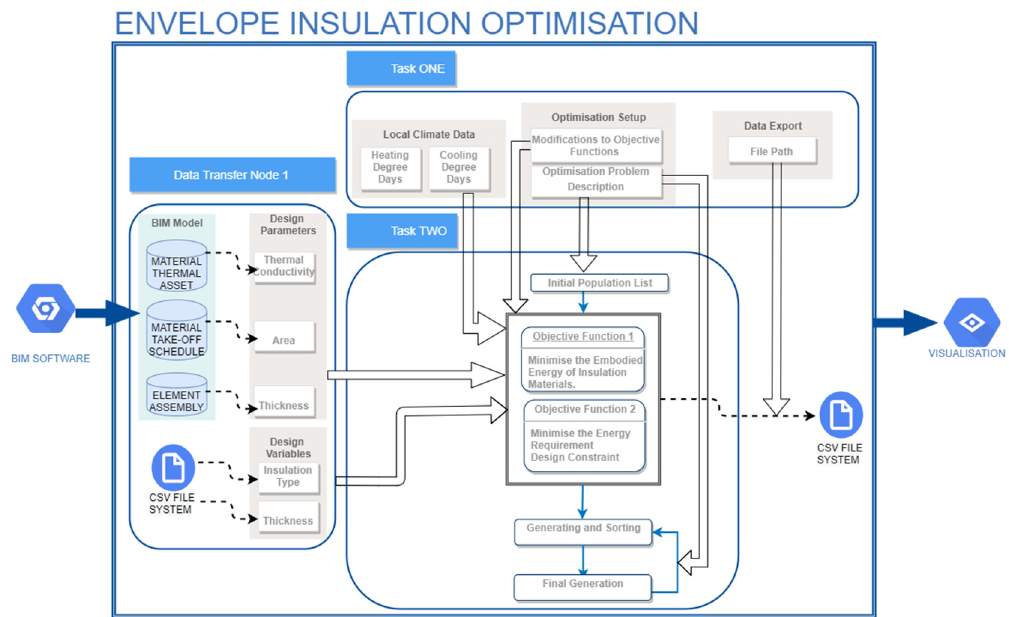
Figure 2. Module Envelope Insulation Optimisation Workflow.